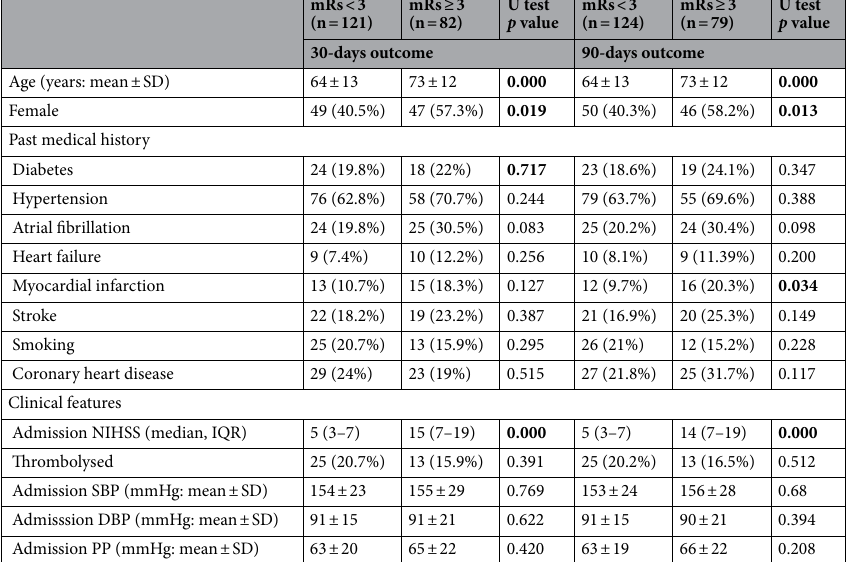
Table 1. Baseline characteristics of two study cohorts for 30-days and 90-days post-stroke outcome. DBP: diastolic blood pressure; mRS: modified Rankin scale; NIHSS: National Institutes of Health Stroke Scale; PP: Pulse Pressure; SD: standard deviation; SBP: systolic blood pressure. Significant values are in